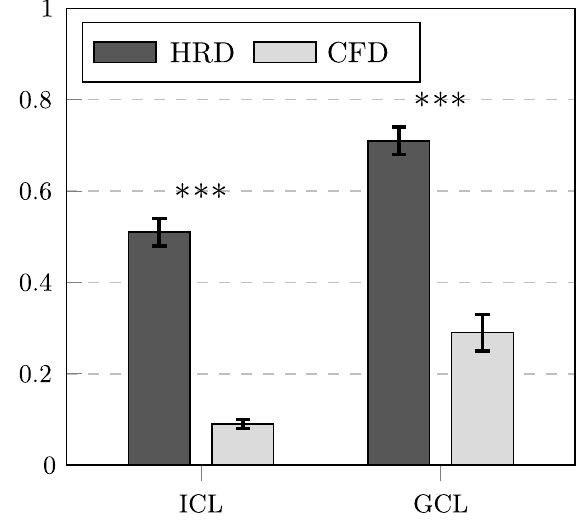
FIG. 7. Results for intrinsic cognitive load and germane cognitive load in a comparison of dealing with the HRD and an isomorphic x - y diagram. Error bars indicate the standard errors of the mean